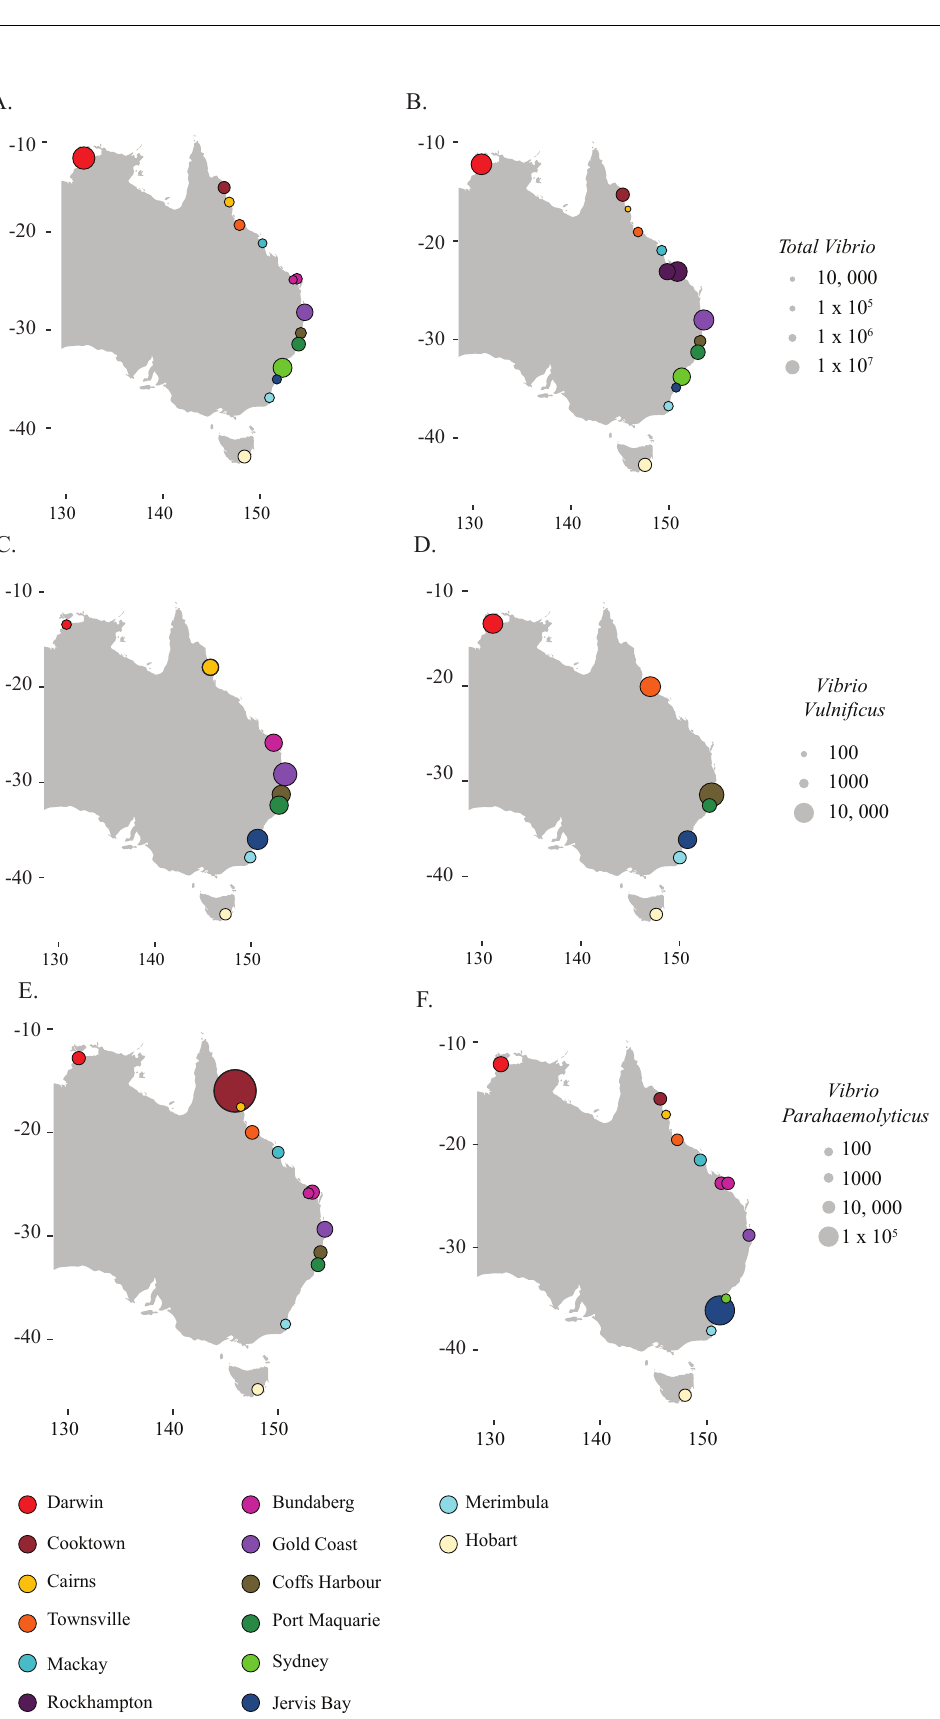
Figure 3. Results from ( A , B ) Total Vibrio qPCR, ( C , D ) Vibrio vulnificus ddPCR, ( E , F ) Vibrio parahaemolyticus ddPCR. ( A , C , E ) are river sites, while ( B , D , F ) are beach sites. Size scale represents copies/L of each